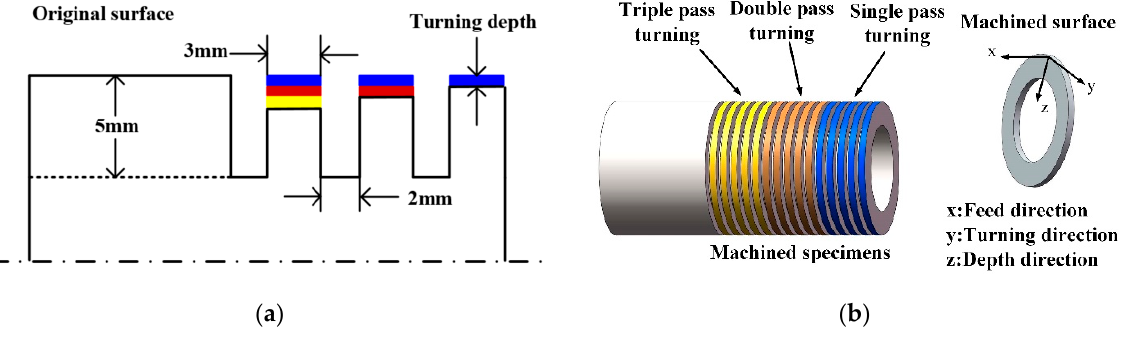
Figure 2. Schematic diagram showing multi-pass turning for the specimens: ( a ) multi-pass turning process and ( b ) workpiece after multi-pass turning and